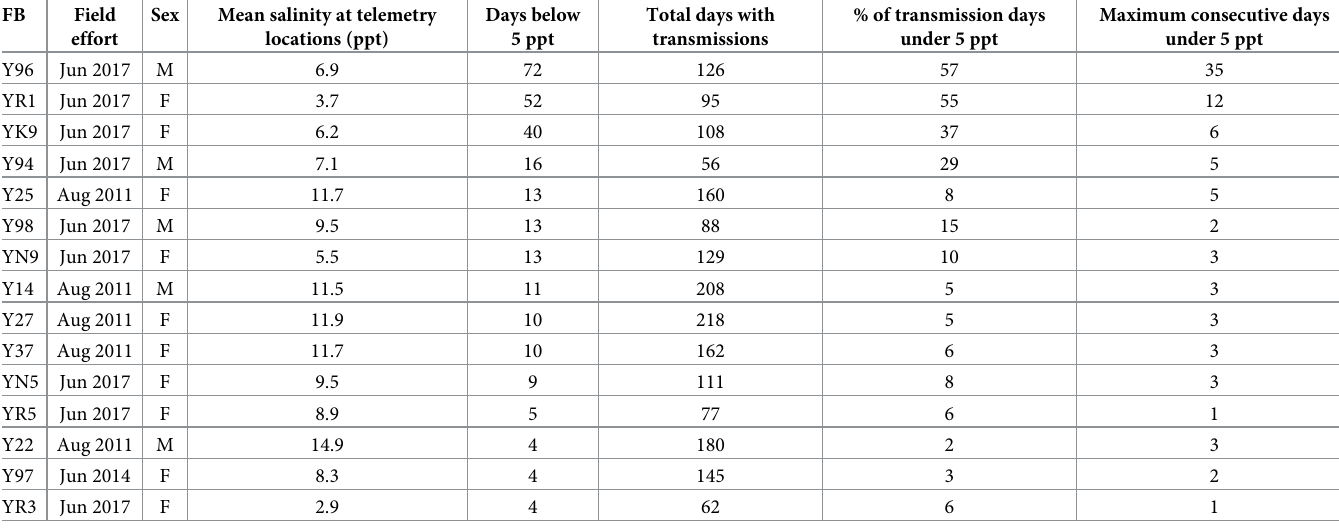
during that 48 hour gap, but that transmissions more than 48 hours apart allowed for the dolphin to move into waters > 5 ppt (parts per thousand).